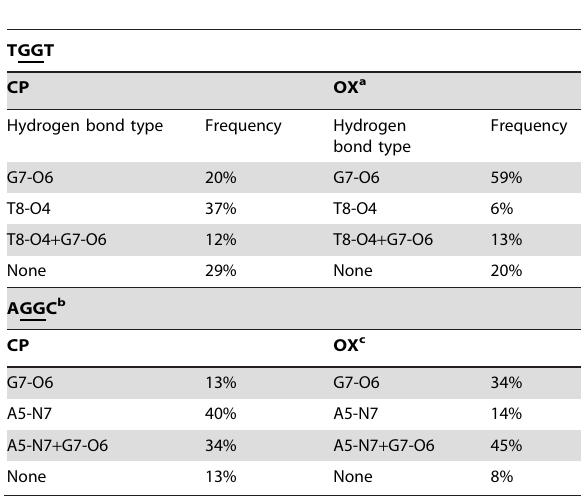
Table 1. Distribution of hydrogen bonds between Pt-amines and adjacent bases observed in MD